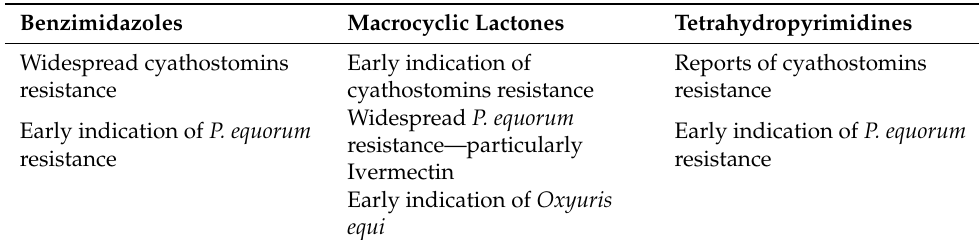
Table 1. Summary of the resistance status of the three authorised anthelmintic classes in the UK.